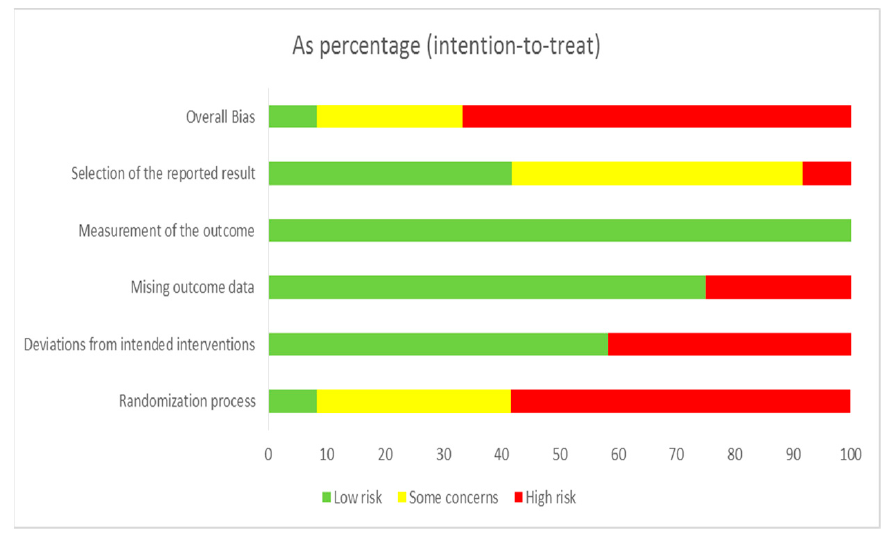
Figure 3. Risk of bias summary.